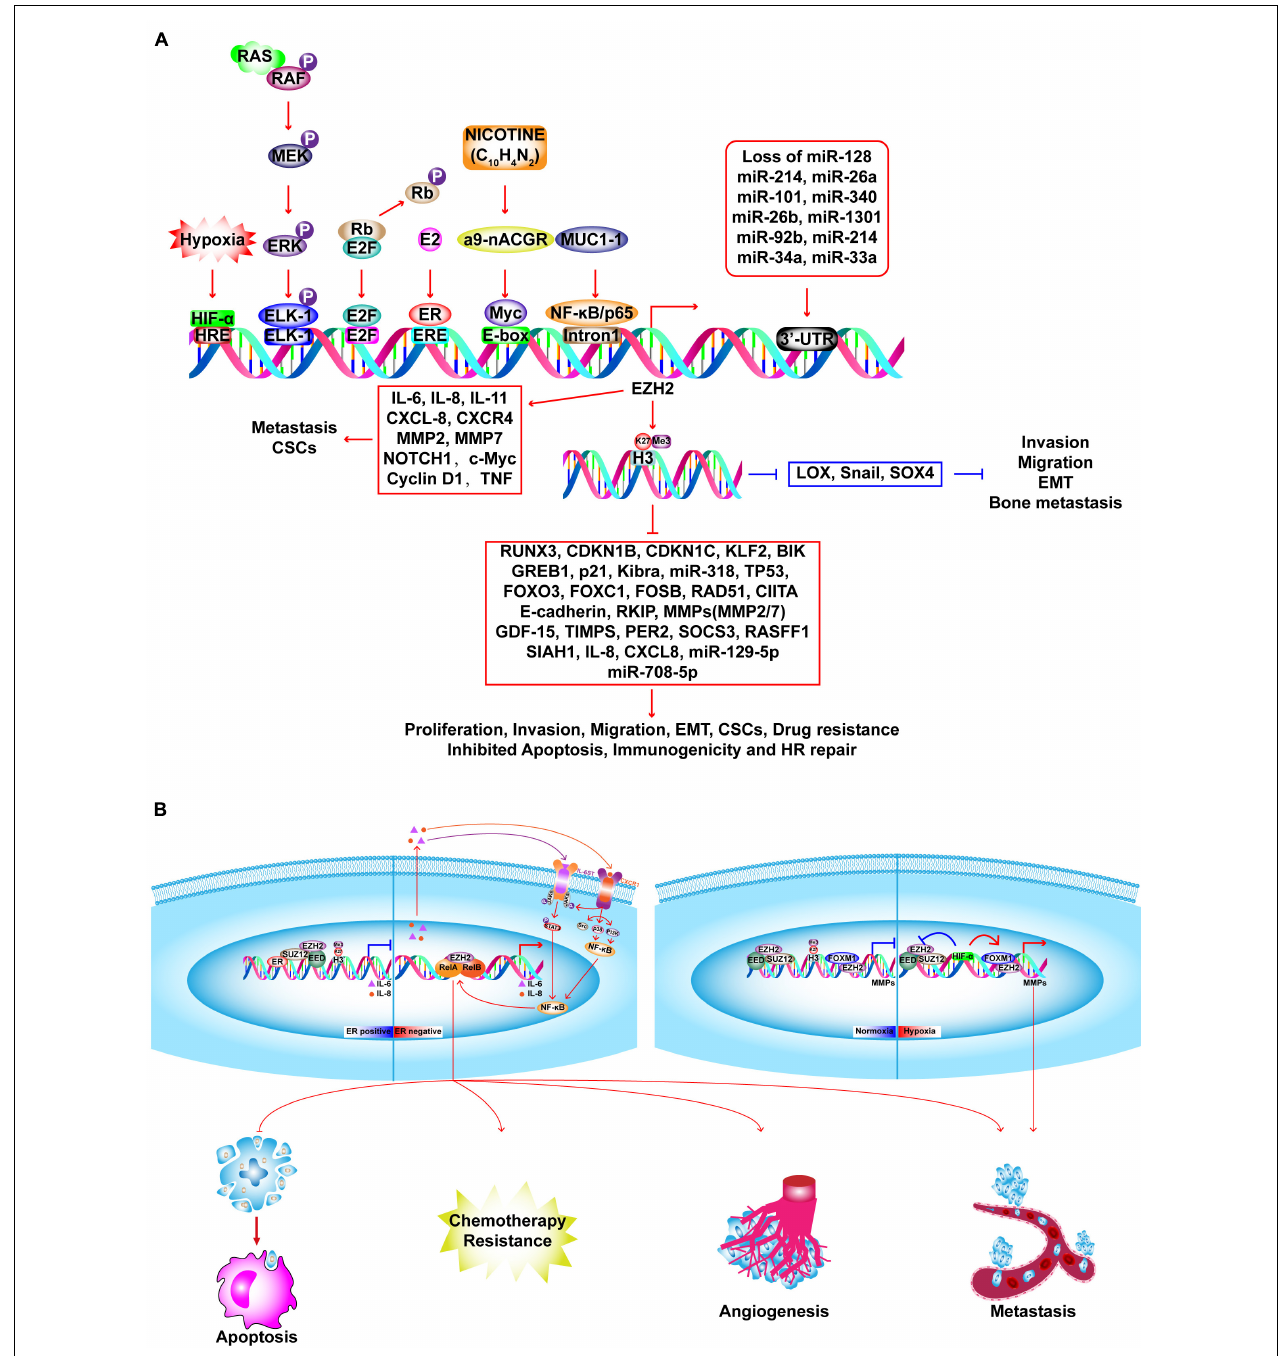
FIGURE 6 | Molecular insights into EZH2-driven BC tumorigenesis. (A) In BC cells, EZH2 expression is upregulated by several factors and loss of microRNAs. Upregulated EZH2 elevate the H3K27me3 and transcriptional repression of several TSGs, such as RUNX3 , CDKN1B , CDKN1C , which promote the proliferation, invasion, migration, EMT, CSCs, drug resistance and inhibit apoptosis, immunogenicity and HR repair. EZH2 promotes activation of oncogenes in a PRC2-independent manner, such as IL-6 , CXCL-8 , NOTCH1 , MMP2/7 , etc. EZH2 suppresses invasion, migration, EMT, and bone metastasis via inhibiting LOX , SNAIL , and SOX4 . (B) EZH2 executes context-dependent activation which can be either dependent or independent on its methyltransferase activity. In ER-positive BC, ER recruits PRC2 complex to the promoter of NF- κ B target genes ( IL-6 , IL-8 ) to inactivate transcription. In ER-negative basal-like BC, EZH2 acts as a co-activator of RelA and RelB to promote the expression of IL-6 , IL-8 , and IL-11 which in turn activates NF- κ B signaling pathway through a positive feedback leading to constitutive activation of these genes and anti-apoptosis, angiogenesis, metastasis, and chemotherapy resistance. In TNBC, upon normoxia, PRC2 inactivates matrix metalloproteinase gene ( MMPs ) by catalyzing H3K27me3 at the promoter region. Upon hypoxia, HIF1- α inhibits PRC2 activation by repressing protein expression of SUZ12 and EED, leading to functional switching to EZH2/FOXM1-depedent induction of MMPs expression.